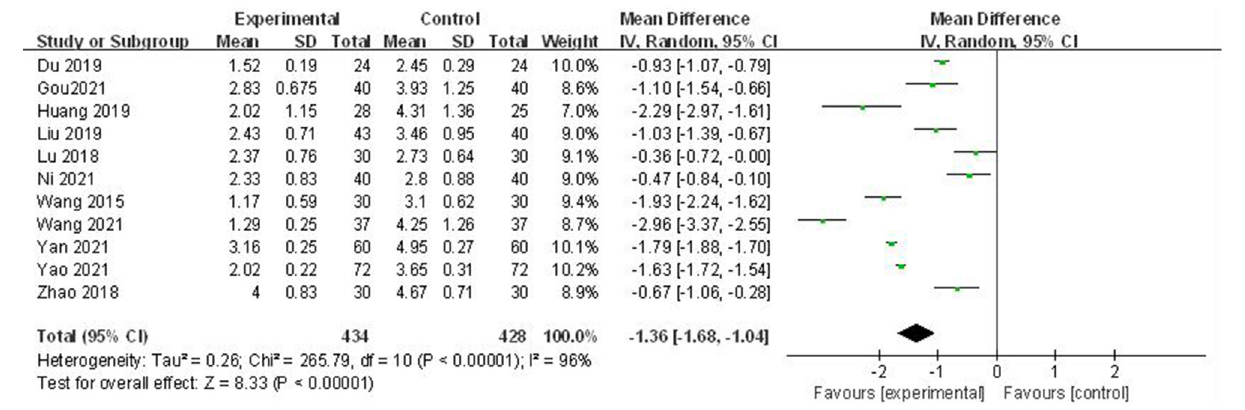
FIGURE 3 | Forest plots of acupuncture plus control treatment vs. control treatment: pain intensity.